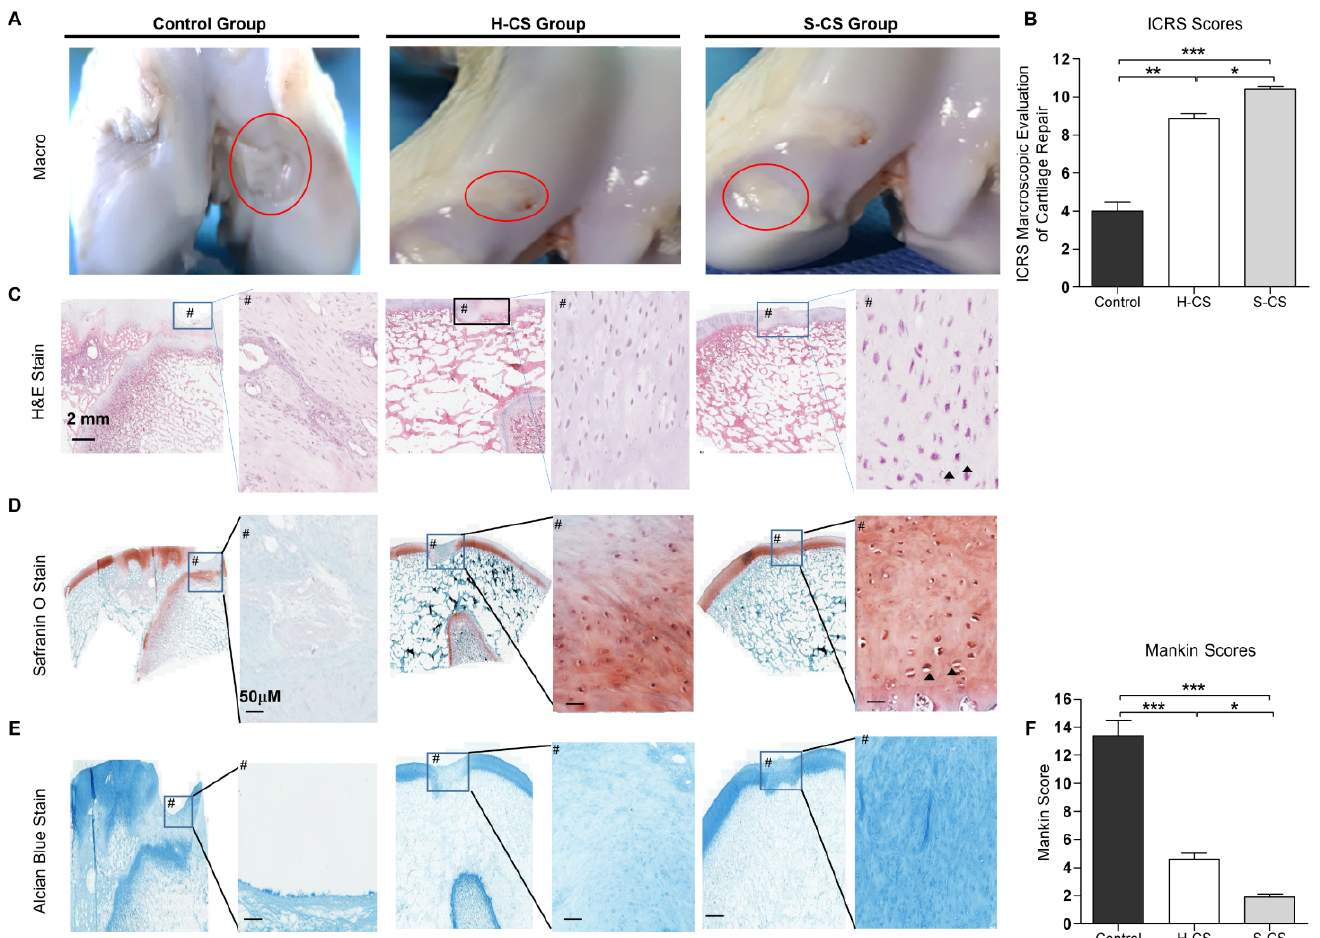
Figure 6. Macroscopic and histological observation of regenerated cartilage. ( A ) Photographs represent porcine knee articular defect healing in the control, heterogeneous chondrocyte sheets (H-CS), and stratified chondrocyte sheets (S-CS) groups at 12 weeks after surgery. The red circles indicate the original defect margin. ( B ) International Cartilage Repair Society (ICRS) macroscopic assessment scores of repaired cartilages at 12 weeks. Data are presented as mean ± SD. ( C ) H&E staining. Boxes in left panels represent magnified area shown in right panels. ( D ) Staining results of Safranin O/Fast green and ( E ) Alcian blue in low-powered (left) and high-powered view (scale = 100 µM) (right image, #). Arrowheads indicate the lacunae. (F) Sections were scored with Mankin score. (*, p < 0.05, **, p < 0.01, ***, p < 0.001).